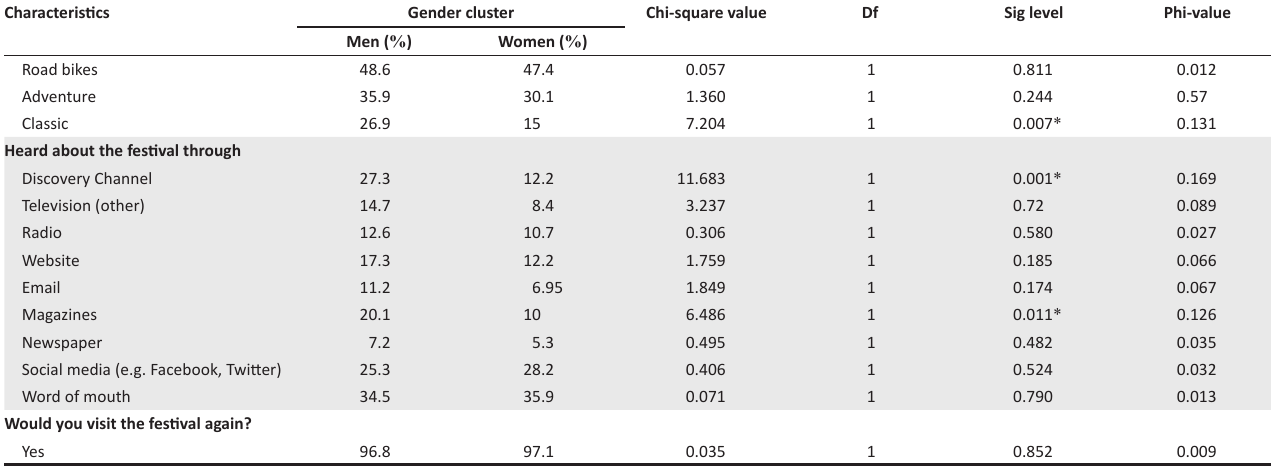
TABLE 3(Continues...): Cross tabulations of socio-demographic characteristics.